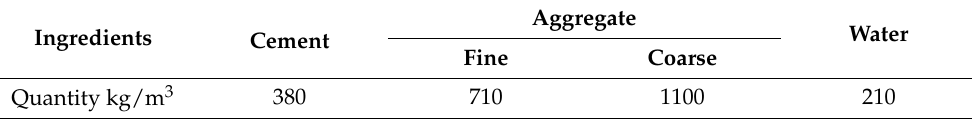
Table 1. Mix proportions of concrete.